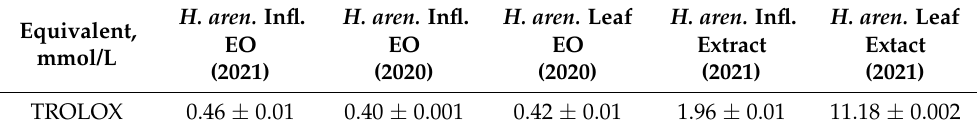
Table 4. Antioxidant activity of H. arenarium essential oils and extracts using ABTS • + assay. H. aren. Equivalent, mmol/L